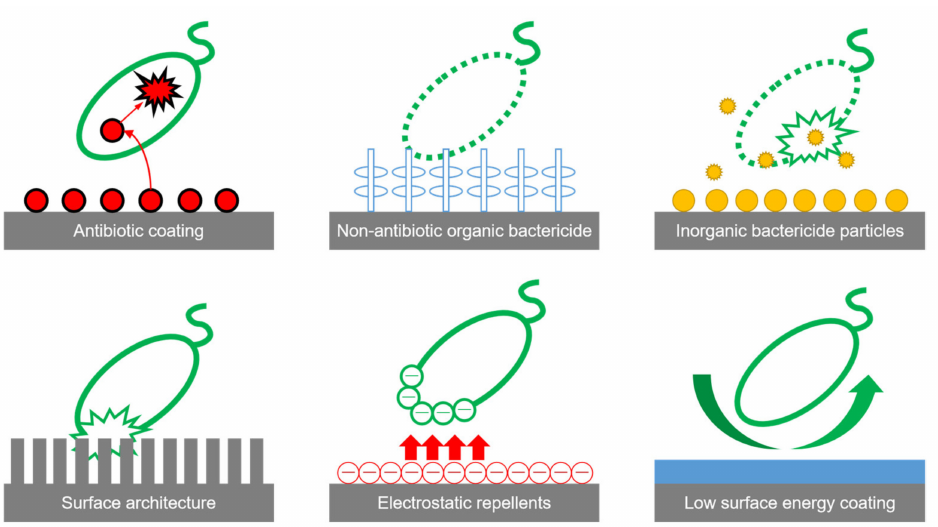
Figure 3. Schematic representation of some antibacterial